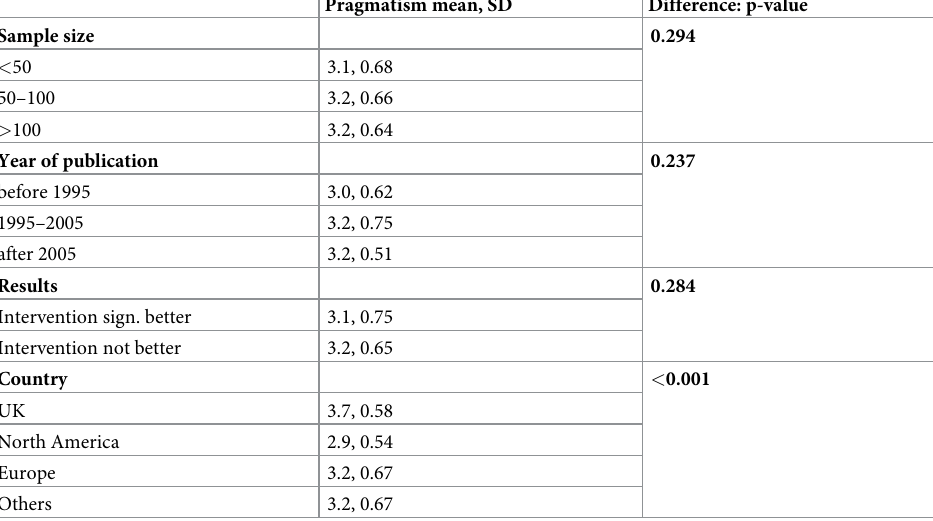
Table 3. Analyses of